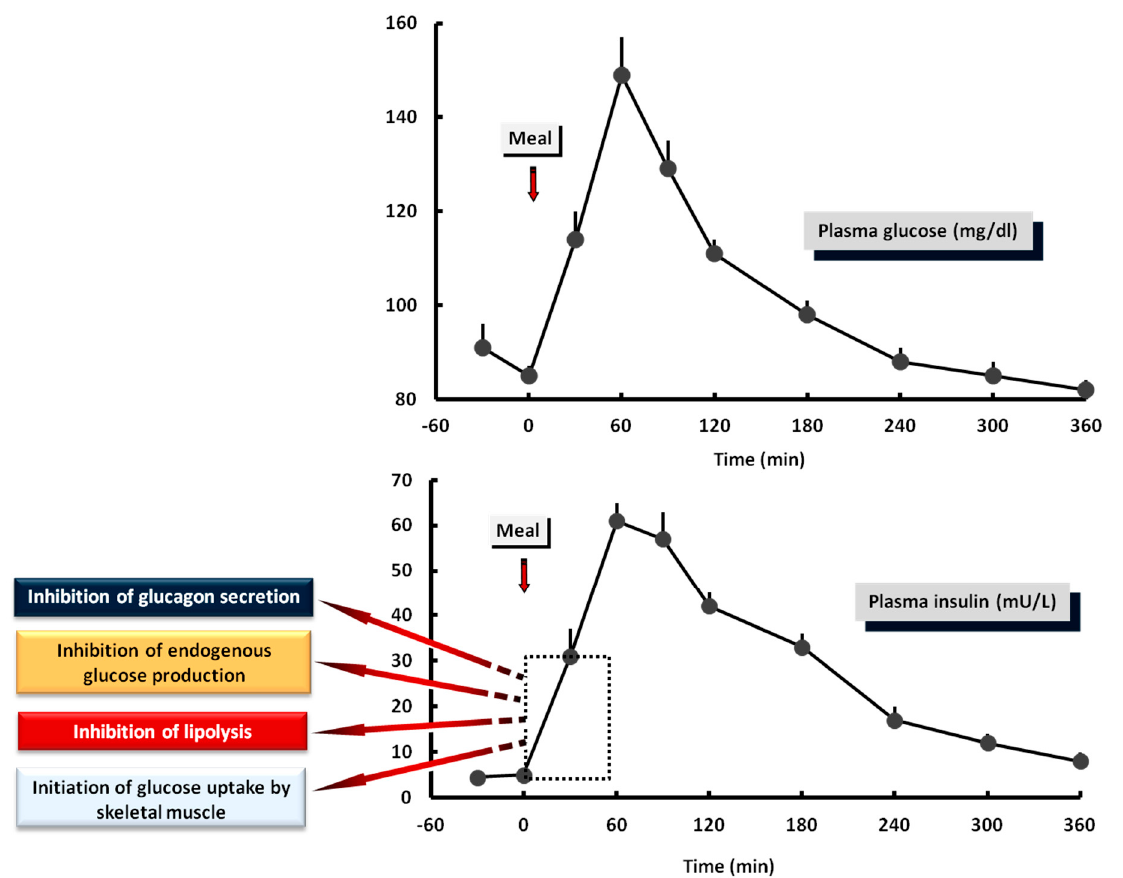
Figure 4. Plasma levels of glucose and insulin after a solid mixed meal in healthy subjects. The early response of insulin: (a) inhibits glucagon secretion from the pancreatic α -cells. (b) Inhibits lipolysis in the adipose tissue. (c) Suppresses endogenous glucose production. (d) Initiates glucose uptake from skeletal muscle. These preliminary effects of insulin start within the first 30 min after the beginning of the meal and are critical for optimal glucose regulation in the postprandial period.